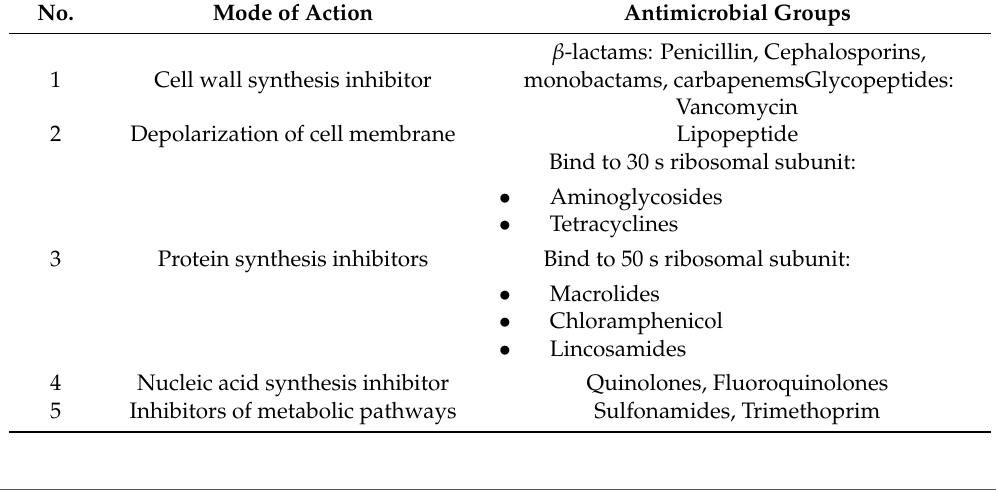
Table 1. Antimicrobial groups based on their mode of action [26].